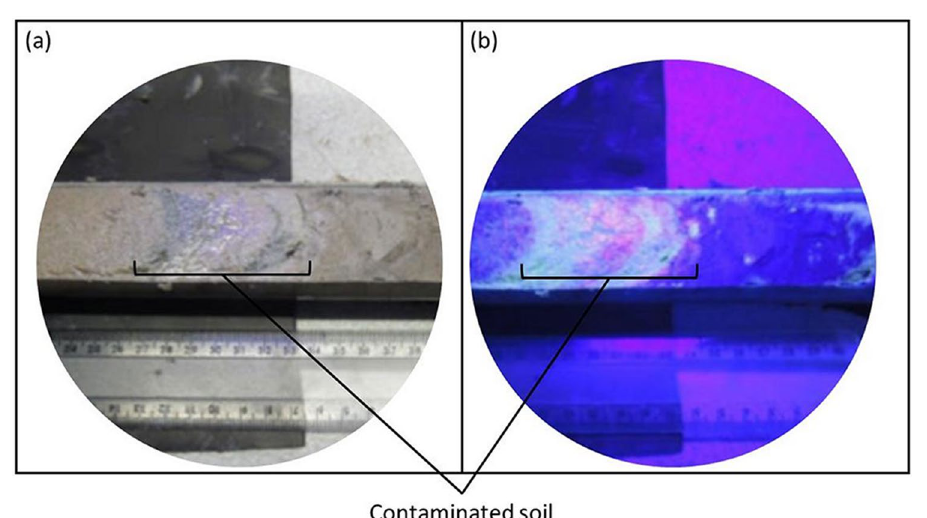
Figure 2. ( a ) Photograph of a section of core SD35, showing a layer of contaminated soil. ( b ) Photograph of the same core as in ( a ), showing the UV reflection by UV light of 380–420 nm (UV-A), reflection by the